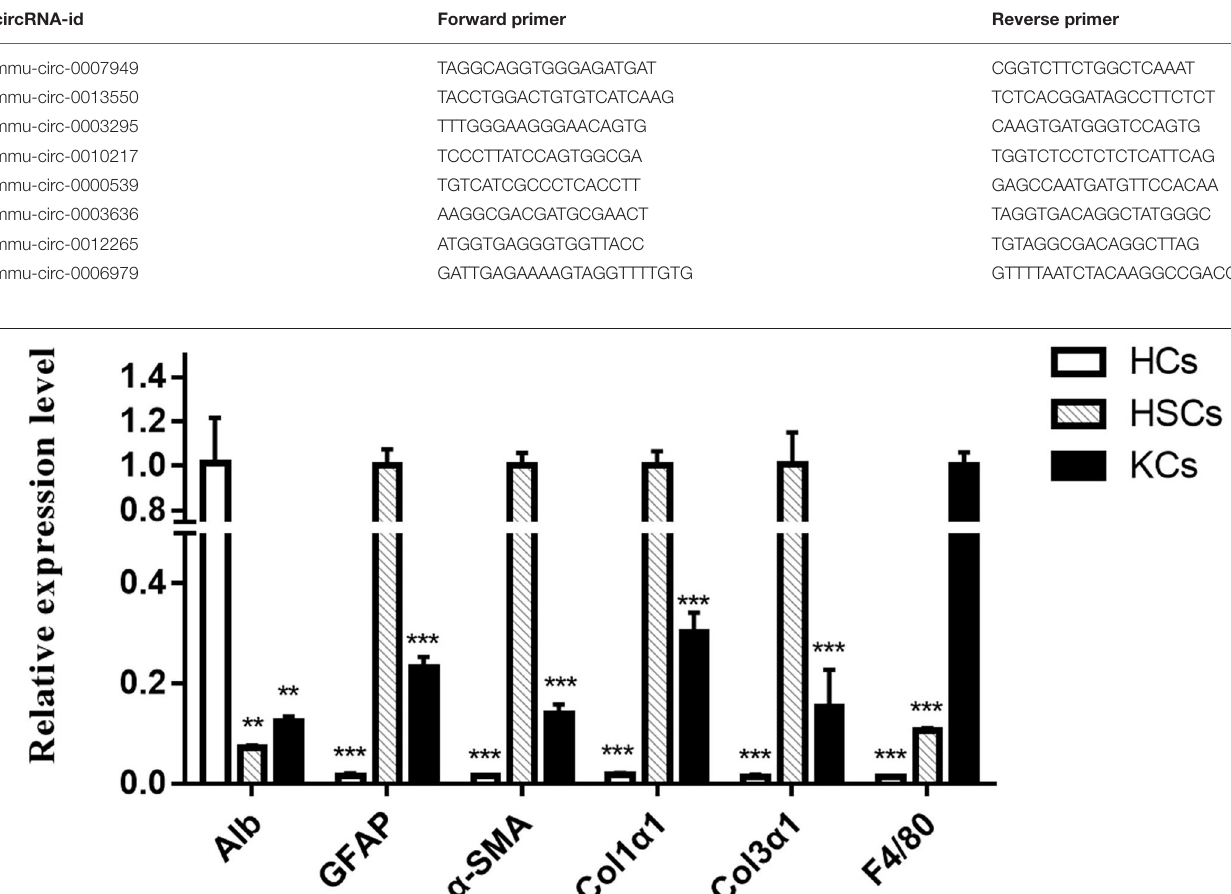
TABLE 1 | The primers of circRNAs used for qRT-PCR validation.